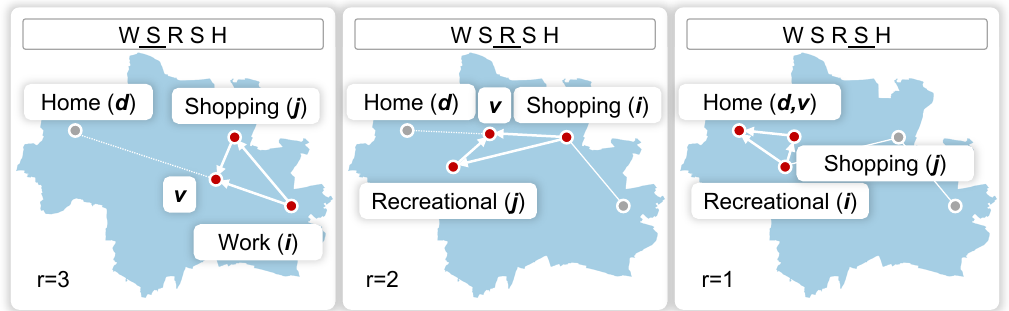
Figure 7. Exemplary illustration of determining secondary activity locations for an activity chain with three secondary activities (from left to right). The activity assigned in the current step is underlined. The virtual destination v always lies on the direct line between the previously assigned activity location i and the destination d and is applied for calculating the detour. Bold arrows represent the distances applicable in the respective current